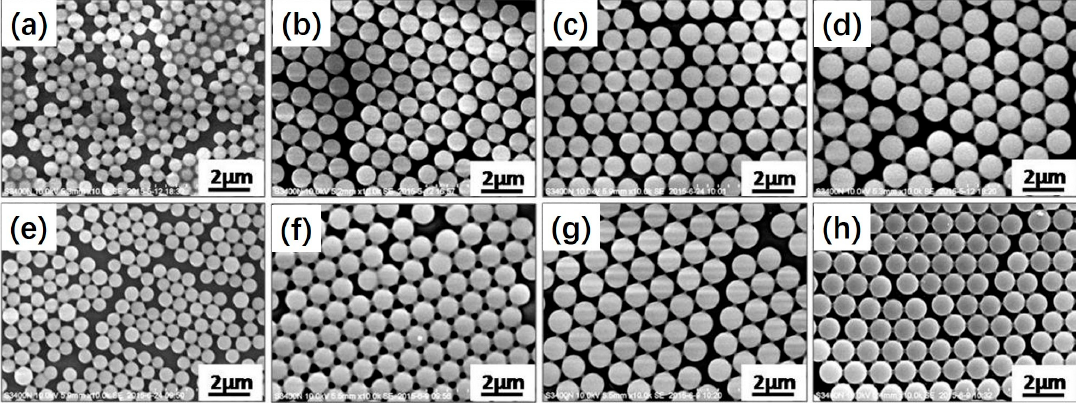
Figure 5. SEM images of polymeric microspheres prepared by photoinitiated RAFT dispersion polymerization of MMA at different HMPP concentrations (1–9 wt %) with either ( a – d ) 2 or ( e – h ) 6 wt % MAA: ( a , e ) 1 wt % HMPP, ( b , f ) 3 wt % HMPP, ( c , g ) 6 wt % HMPP, ( d , h ) 9 wt %